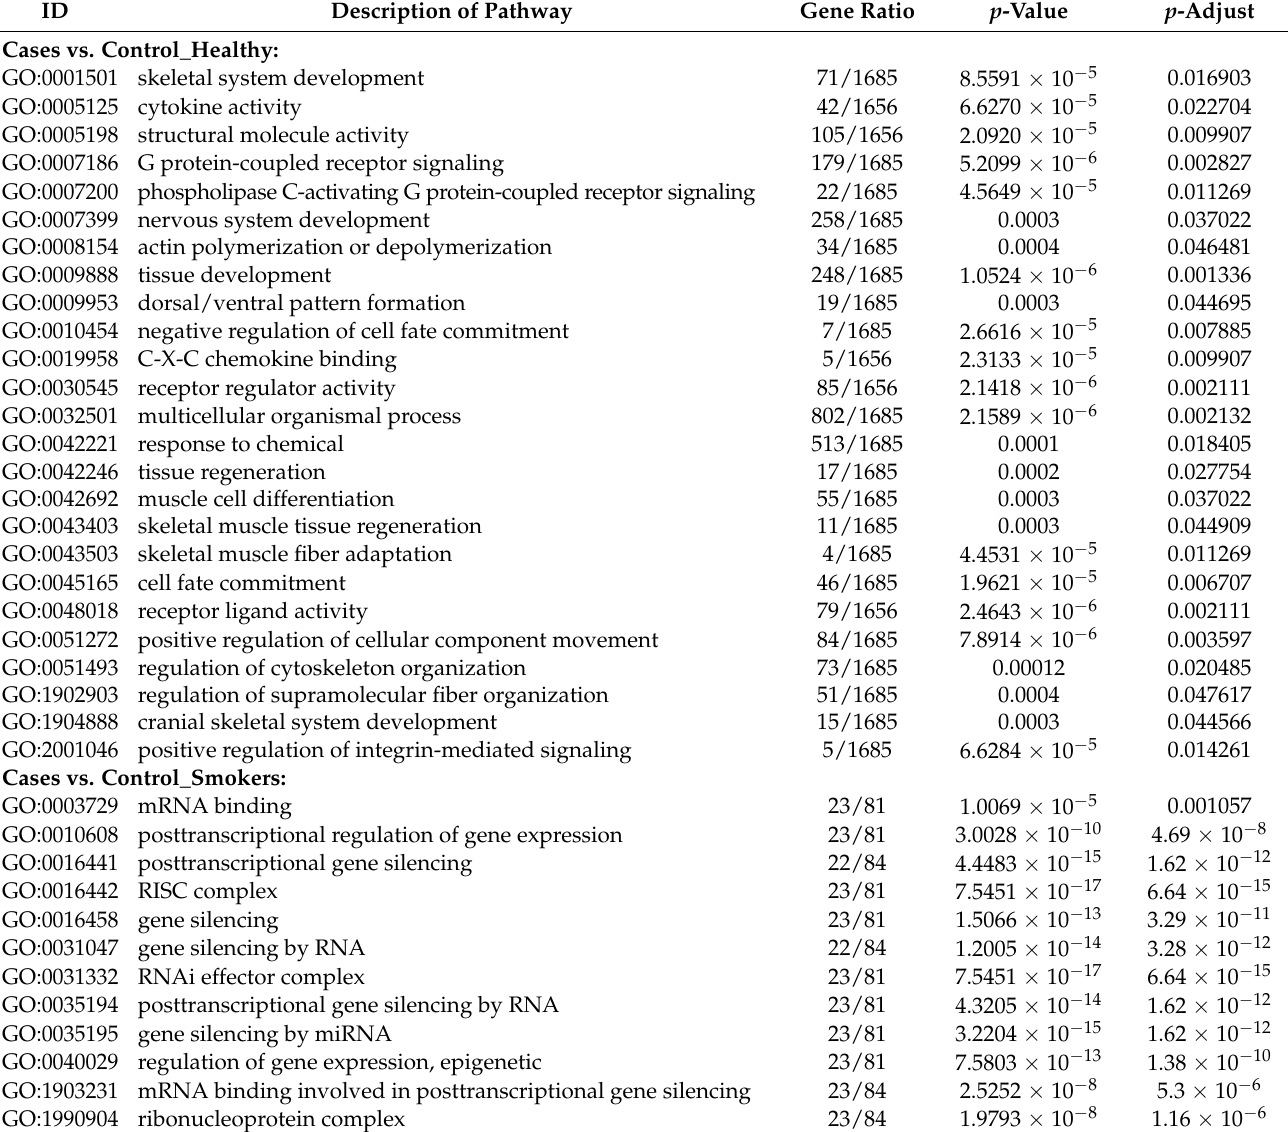
Table 3. Enriched pathways in cases compared with the two control